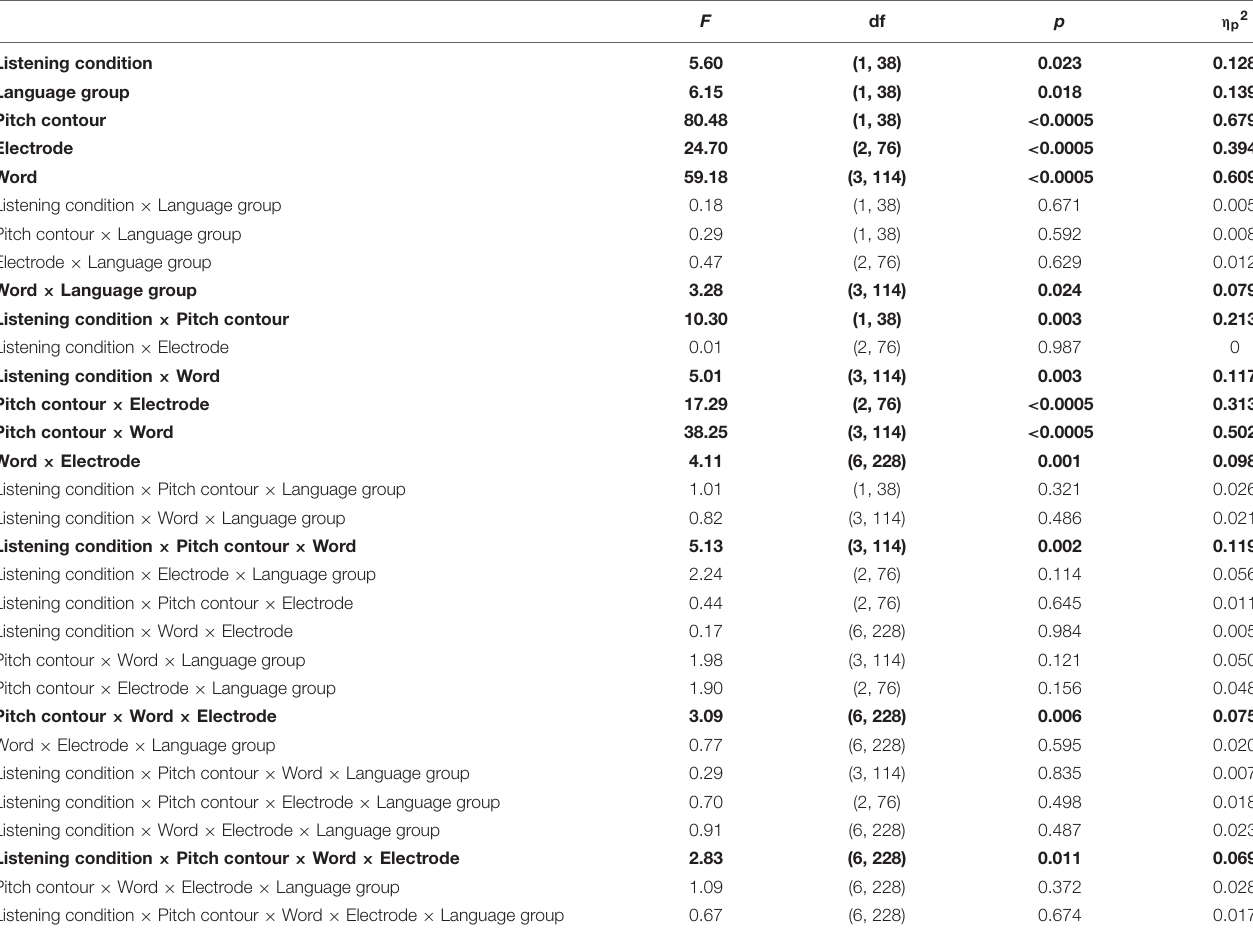
TABLE 4 | Subcortical main effects and interactions for a 2 (language group: monolingual, bilingual) × 2 (listening condition: active, passive) × 3 (electrode: Fz, Cz, Pz) × 2 (pitch contour: male talker, female talker) × 4 (word: ‘ready,’ ‘go,’ ‘to,’ ‘now’) RMANOVA. F df p η